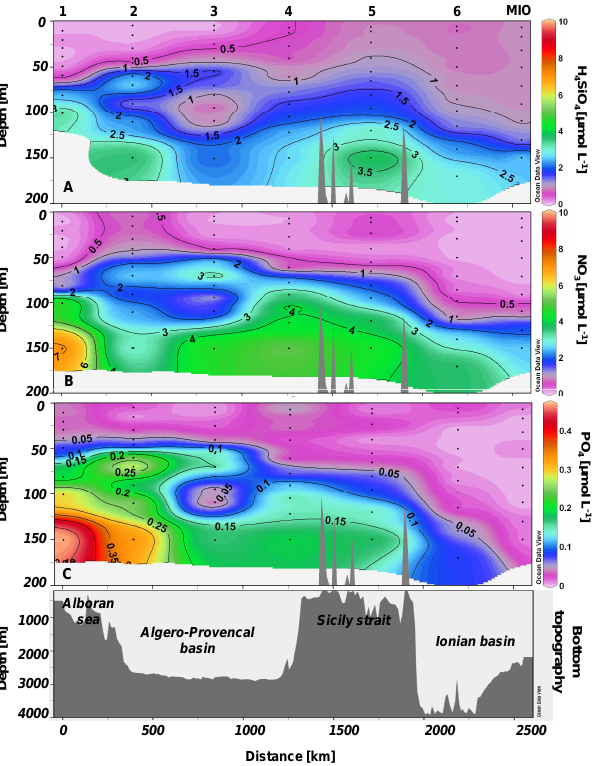
Fig. 3. Nutrient distributions (µM) along the transect 2 during PROSOPE the cruise (summer/fall